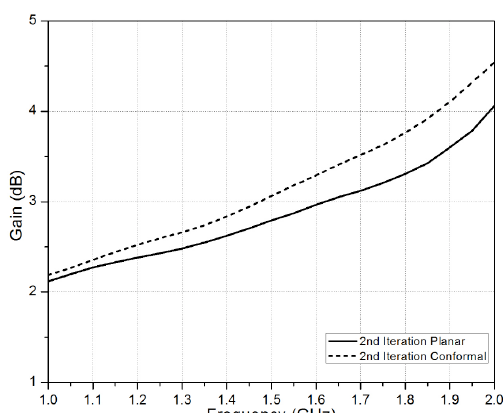
Figure 9: The measured gain plot of planar and conformal antenna.